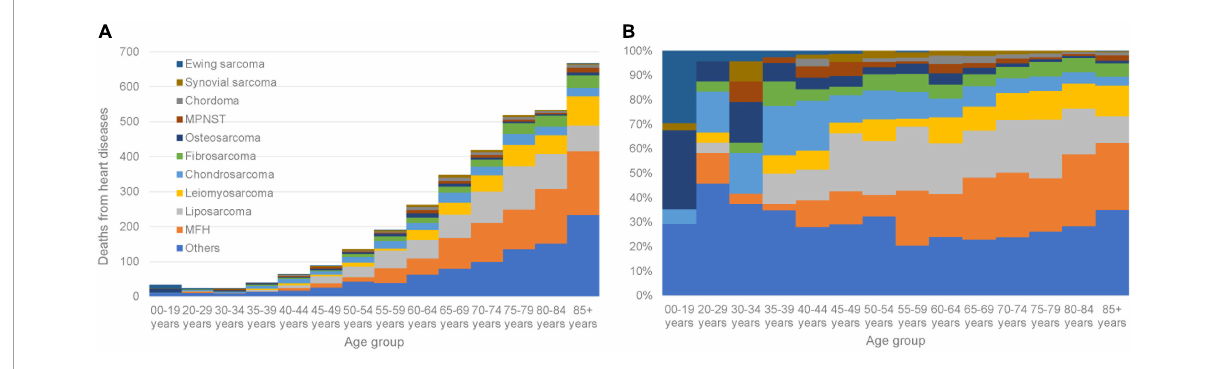
FIGURE2 Fatal HD among sarcoma patients as a function of age group. (A) The y -axis depicts the absolute number of HD deaths and the x -axis depicts the age group at time of diagnosis. The colors depict the histological subtypes of sarcoma. (B) The y -axis depicts the relative number of HD deaths and the x -axis depicts the age group at time of diagnosis. The colors depict the histological subtypes of sarcoma.